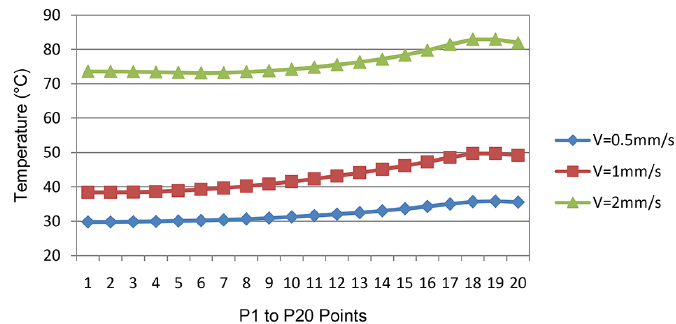
Fig.5: Temperature distribution in the centre line of the work-piece in frictionless condition (immediately after end of the